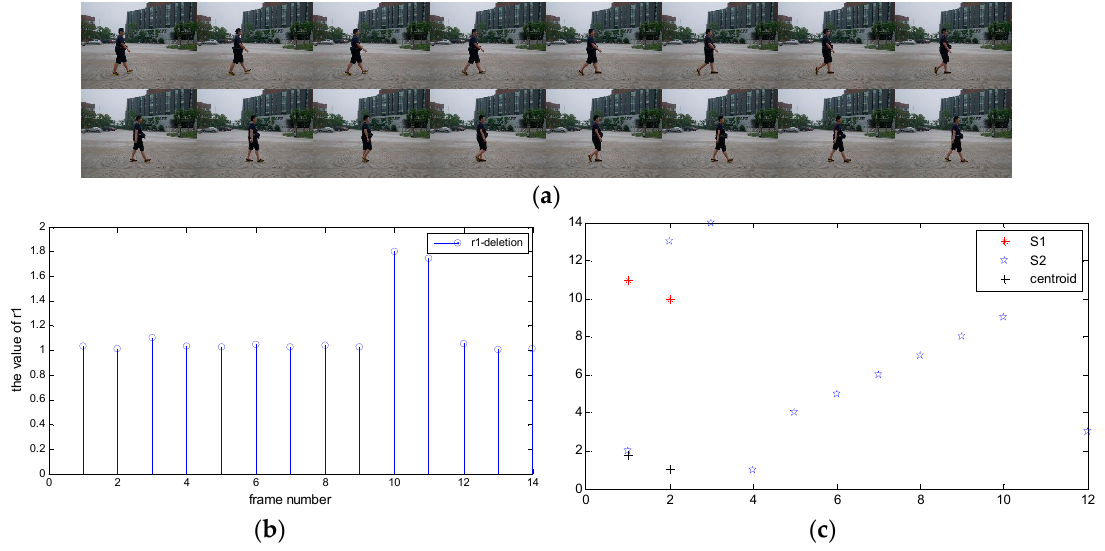
Figure 8. Frame deletion and clustering results. ( a ) Sixteen frames from a video tampered by frame deletion; ( b ) The curve of ∆r1 ; ( c ) clustering results.